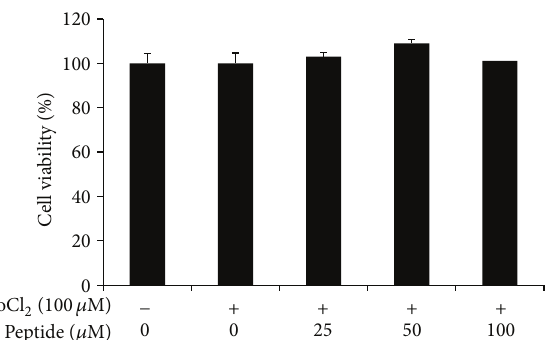
Figure 2: Effect of the S. maxima peptide and CoCl 2 on the viability of HT1080 cells. HT1080 cells were incubated with 100 𝜇 M CoCl 2 and various concentrations of S. maxima peptide for 48 h and assessed using the MTT assay. Results of 3 independent experiments were averaged. All data are presented as mean ±